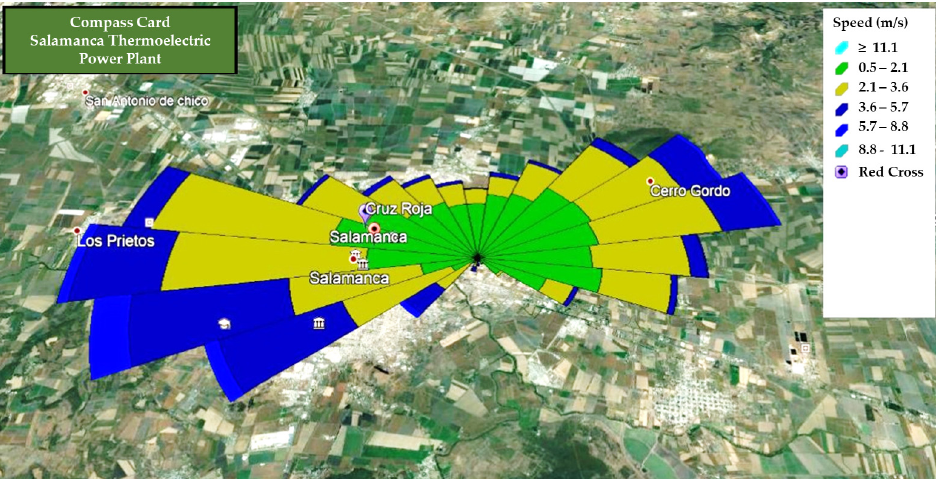
Figure 6. Wind at the RC station Google Earth. Source: Adapted from Google Earth 2020.